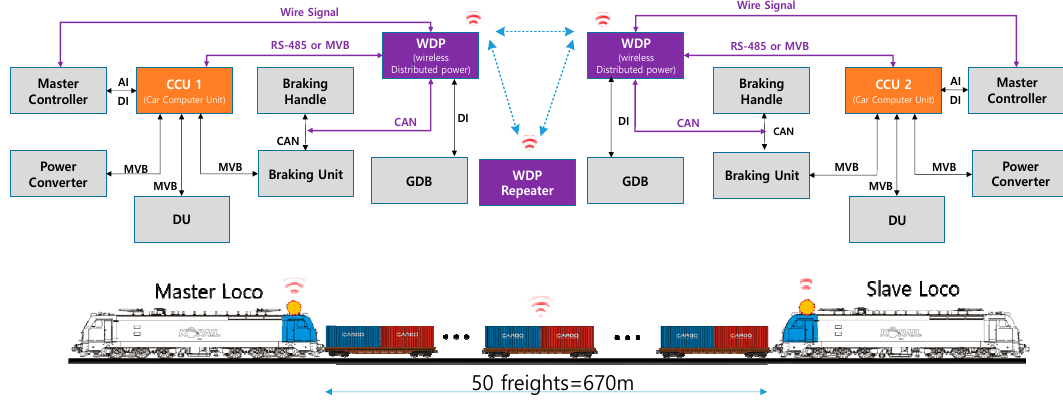
Figure 4. Heavy haul freight configuration.